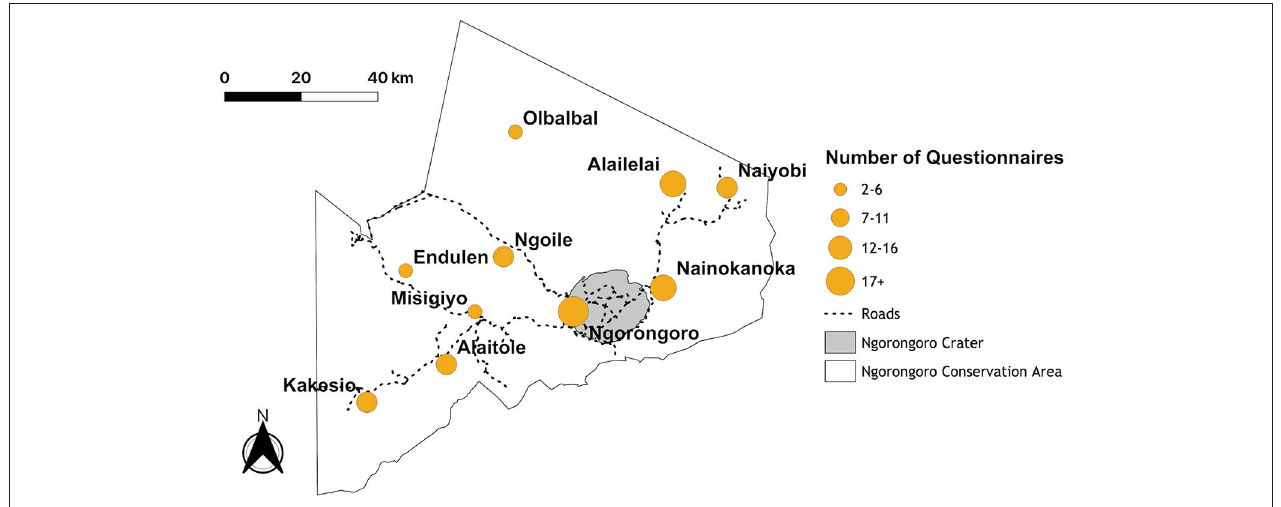
FIGURE 1 | Location and distribution of the 100 questionnaires conducted in the Maasai community living in Ngorongoro Conservation Area, Tanzania. The size of the orange circles indicates the number of questionnaires conducted within each of the ten labeled wards.